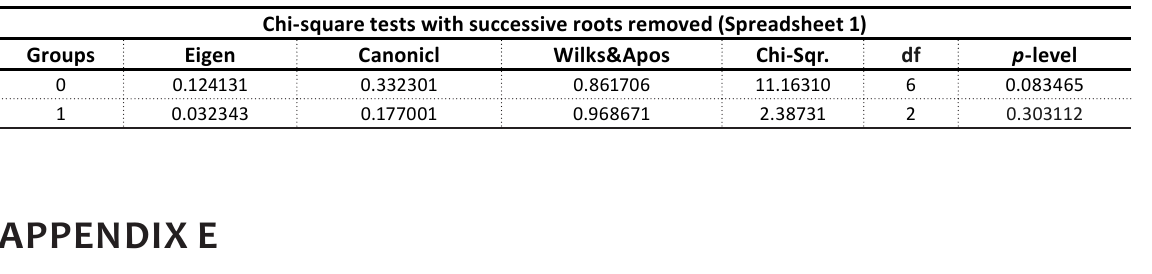
Table E1. Value of coefficients for variables for canonical functions